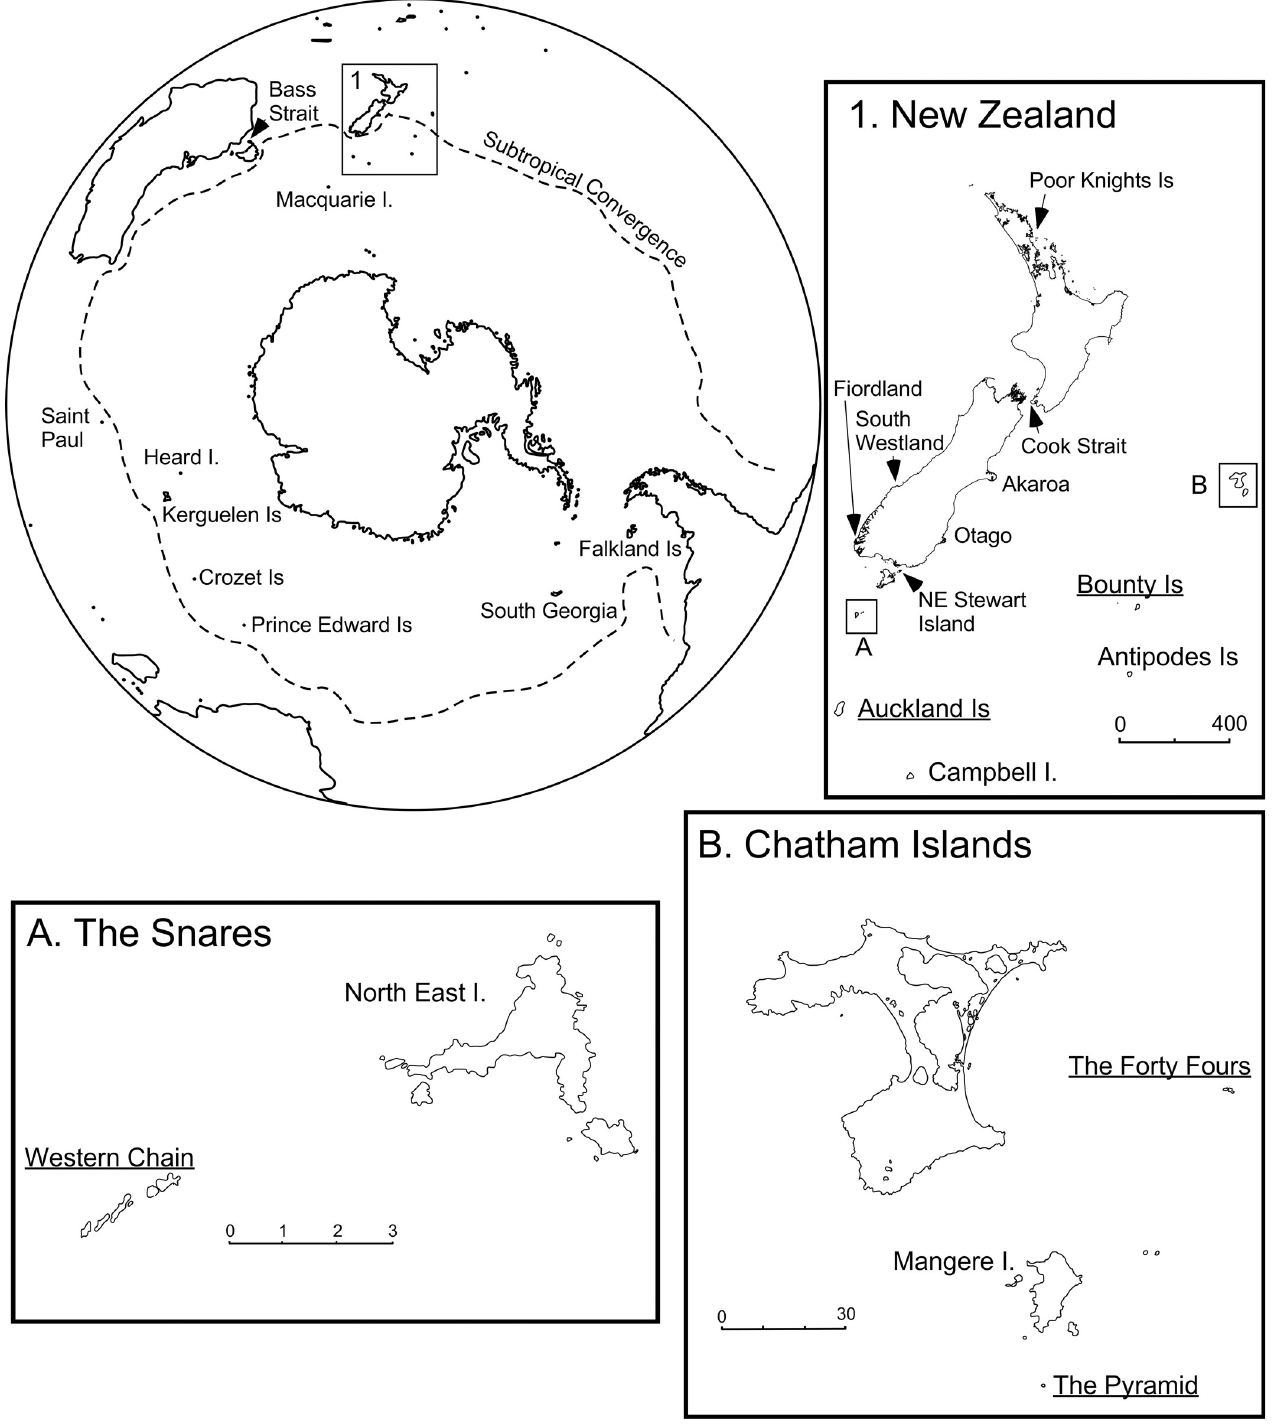
Fig 1. Distribution map of fairy ( Pachyptila turtur ) and fulmar ( Pachyptila crassirostris ) prion breeding colonies. The location names of fulmar prion breeding colonies are underlined and the location of fairy prion breeding colonies shown in bold and not underlined. Inset 1 includes the New Zealand region, insets A and B are within this region. Note that we here report P . crassirostris to be confined to the New Zealand region, with Heard Island birds identified as P . turtur (see